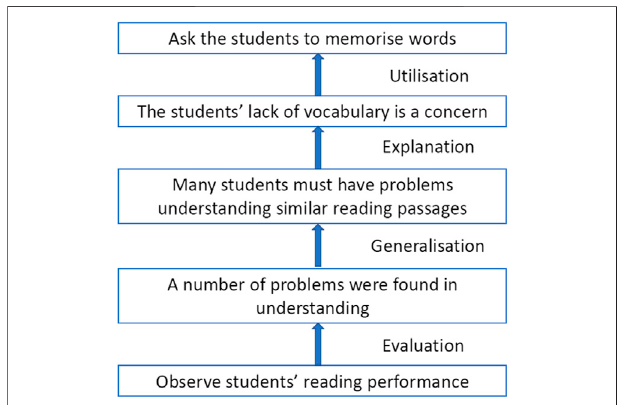
FIGURE 4 | Interpretation and use